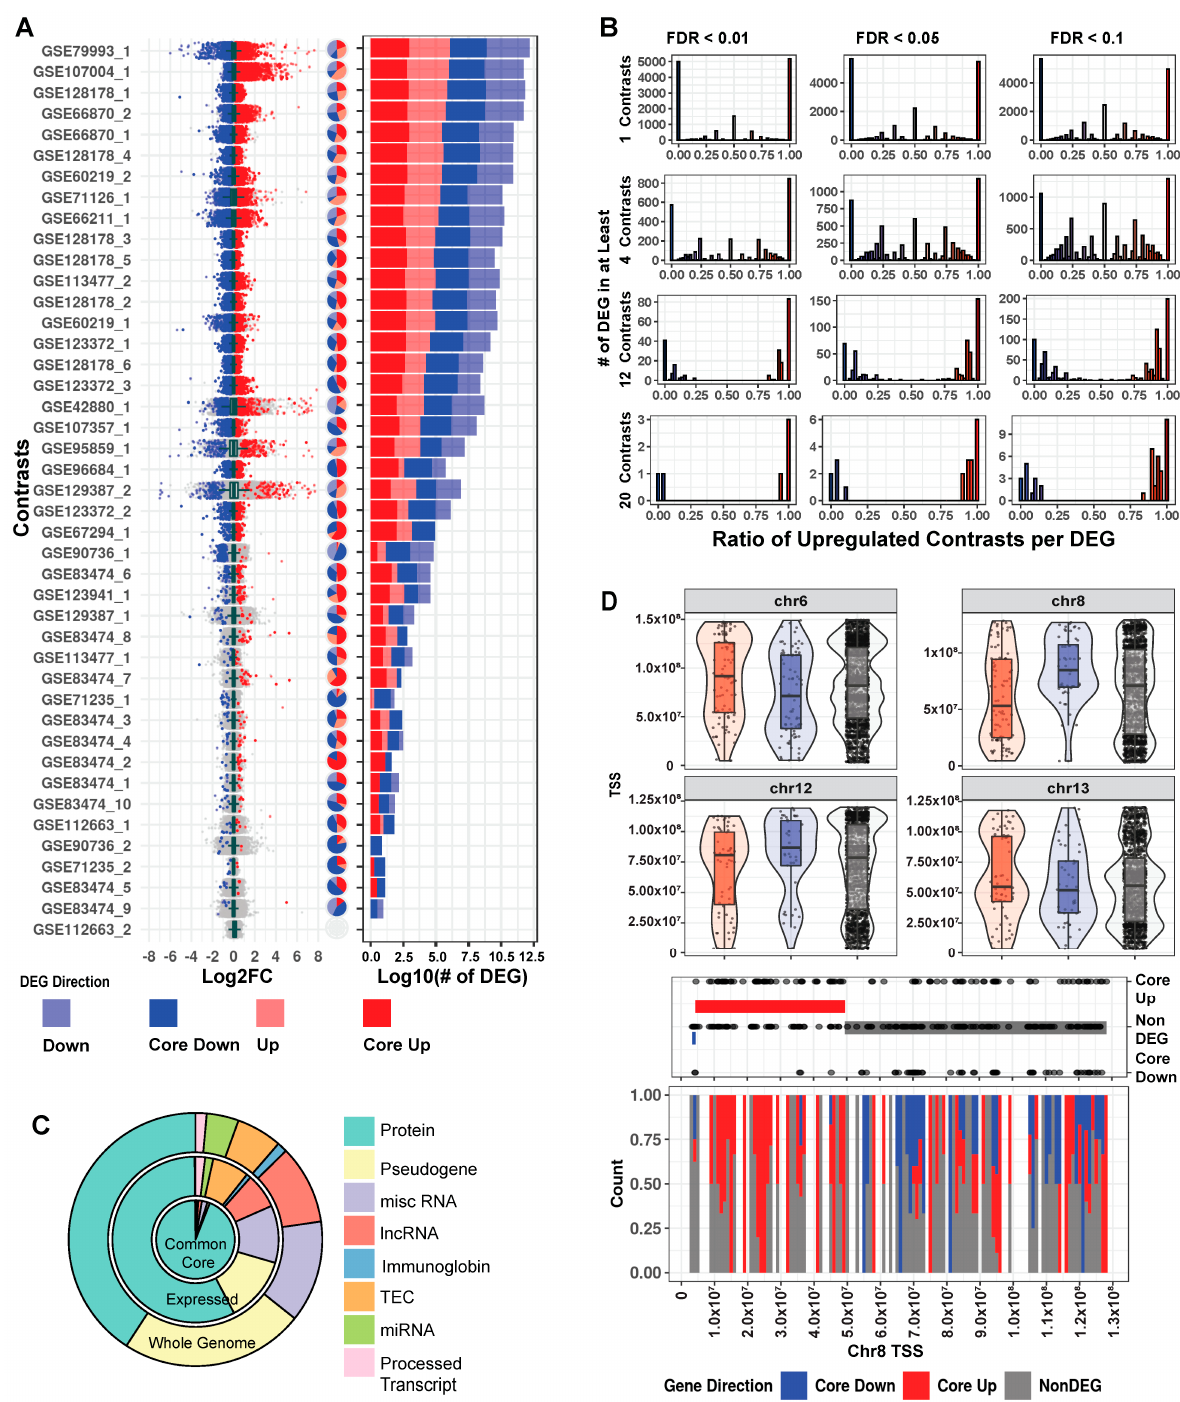
Figure 2. Mouse transcriptome common core. ( A ) Distribution of log2 fold change across contrasts with significant (FDR < 0.01) DEGs. Dark blue and dark red, respectively, indicate genes that are core down and core up, and pale blue/pale red, respectively, indicate down and up DEG. Pie charts with the same annotation colors show what percentage of each contrast’s DEGs falls into each category. Stacked bar charts with the same annotation colors show each contrast’s DEG quantity. ( B ) Histograms of significantly up and downregulated genes cut for different FDR thresholds and the number of total contrasts in which a DEG appears. Genes at the extreme ratios of 0 or 1 percent upregulated are highly concordant across contrasts, whereas genes that fall into the middle